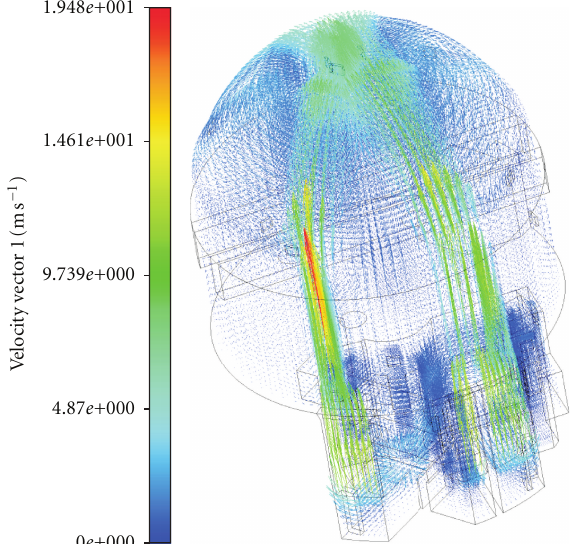
Figure 4: Example of a snapshot of the field of velocities (m/s) in containment rooms.